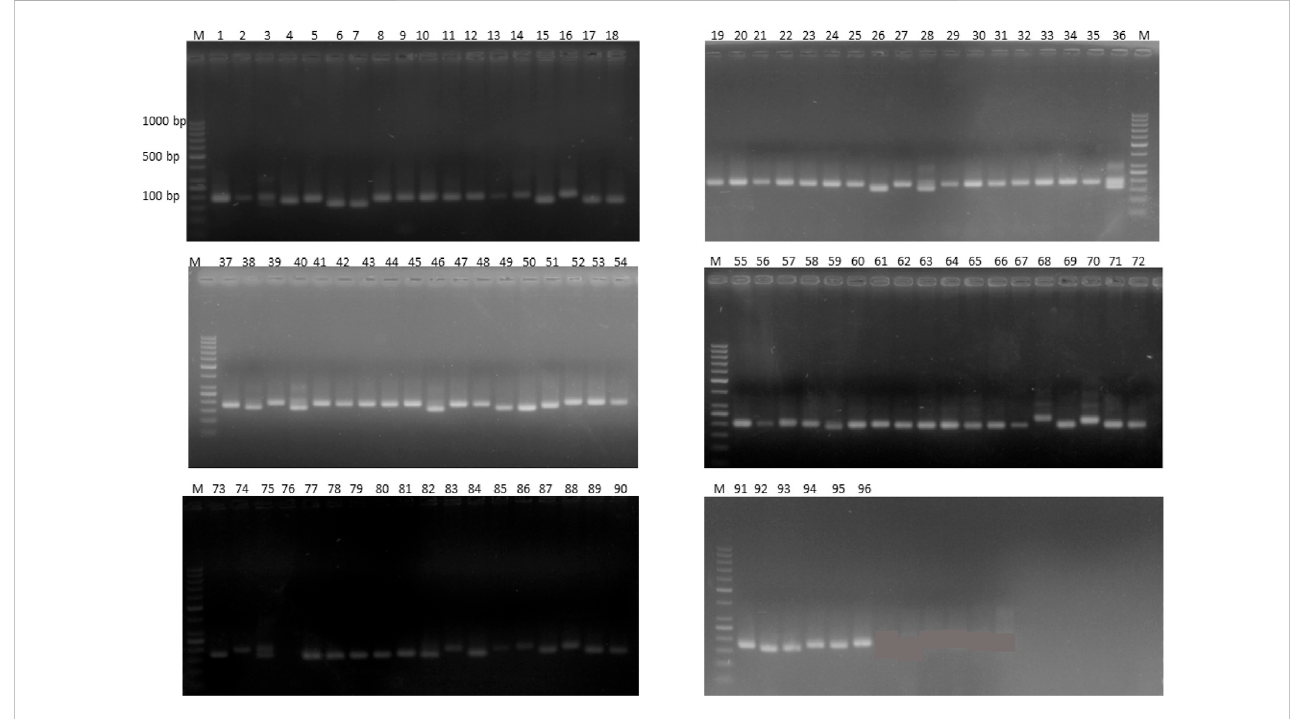
FIGURE 8 Representative gel image of 18 soybean genotypes with SSR marker Satt565 on 2.5% agarose gel. Lane M shows 1 kb plus